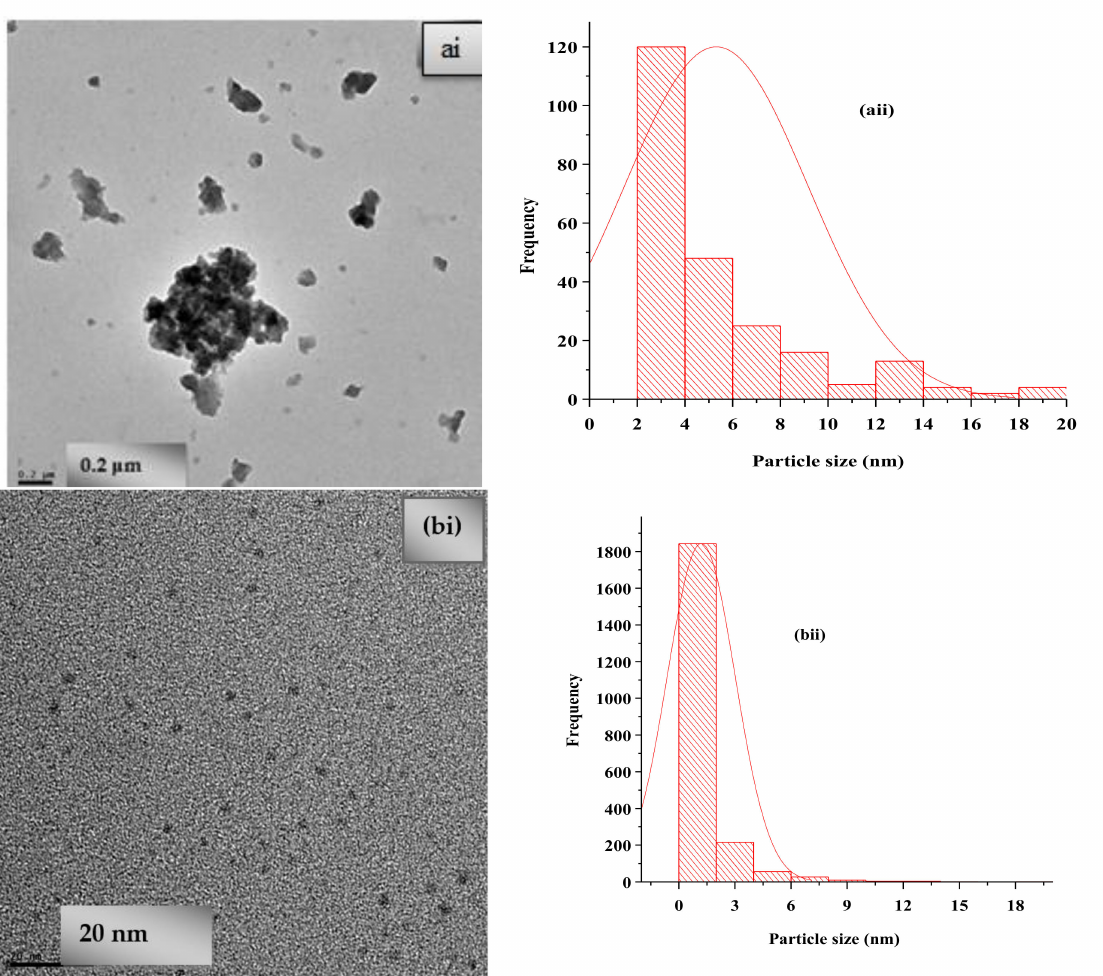
Figure 7. TEM images of ( ai ) Fe 3 O i -NPL and ( bi ) Fe 3 O 4 -NPF and particle size distribution of ( aii ) Fe 3 O i -NPL and ( bii ) Fe 3 O 4